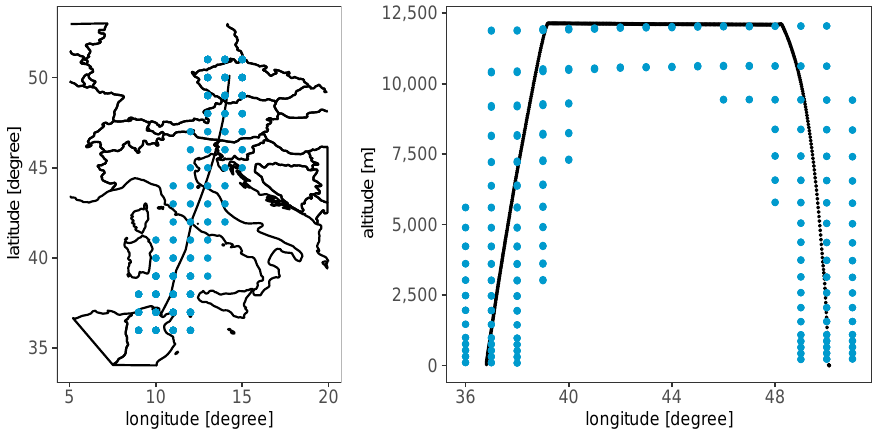
Figure 6. The blue points denote the GFS data used along the trajectory (black curve) from Prague to